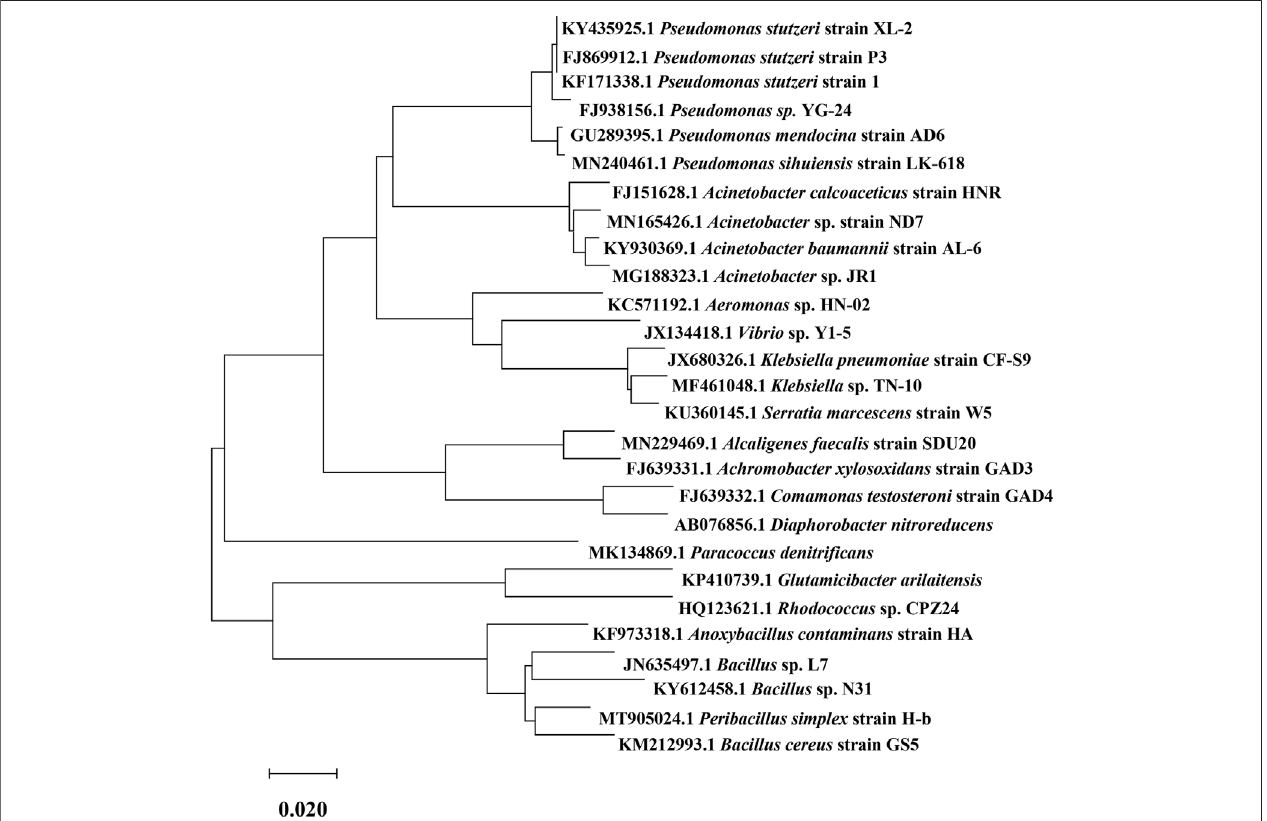
FIGURE 1 | Evolutionary relationship tree of heterotrophic nitrifying and aerobic denitrifying (HNAD) bacteria.